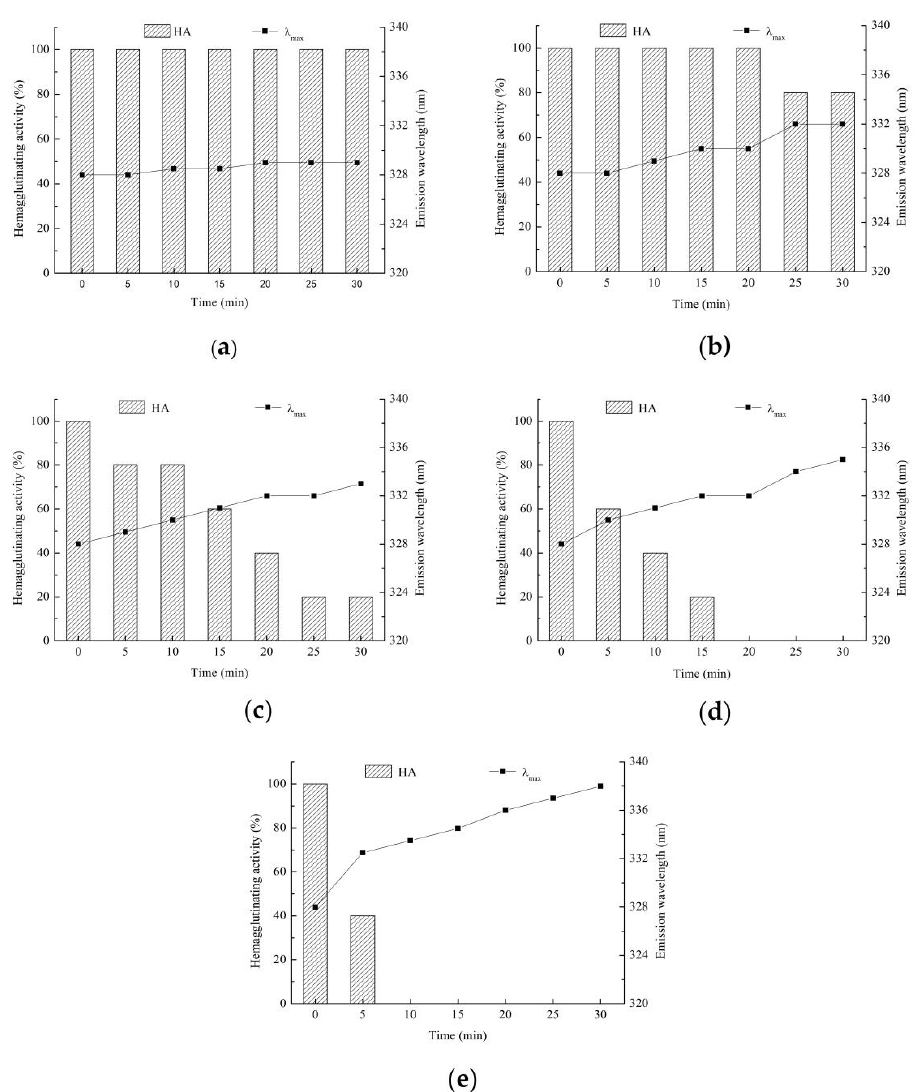
Polymers 2019 , 11 , 785 Figure 6. Hemagglutinating activity changes of lectin at ( a ) 50 ◦ C, ( b ) 60 ◦ C, ( c ) 70 ◦ C, ( d ) 80 ◦ C, and ( e ) 90 ◦ C. Figure 6. Hemagglutinating activity changes of lectin at ( a ) 50 °C, ( b ) 60 °C, ( c ) 70 °C, ( d ) 80 °C, and ( e ) 90 °C.